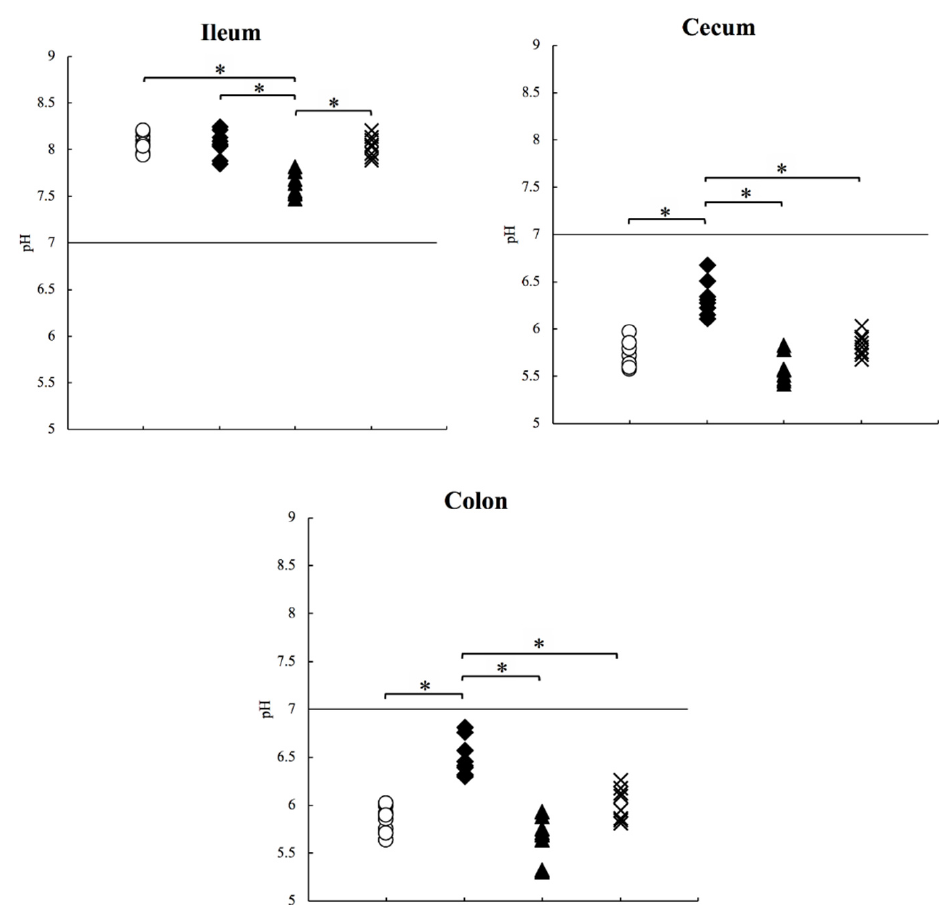
Figure 2. pH values measured in experimental mice under various conditions studied in the following groups. HP, the group with mice that were fed a high-protein diet ( ◆ black diamond); PPI, mice treated with the proton pump inhibitor ( ▲ black triangle); aged, elderly mice at 25–30 weeks of age (× multiplication sign), and control mice ( ○ white circle). * p < 0.05. In the ileum, the difference between HP vs. PPI > Control vs. PPI > Aged vs. PPI. In the cecum and colon, the difference between HP vs. PPI > HP vs. Control > HP vs. Aged.